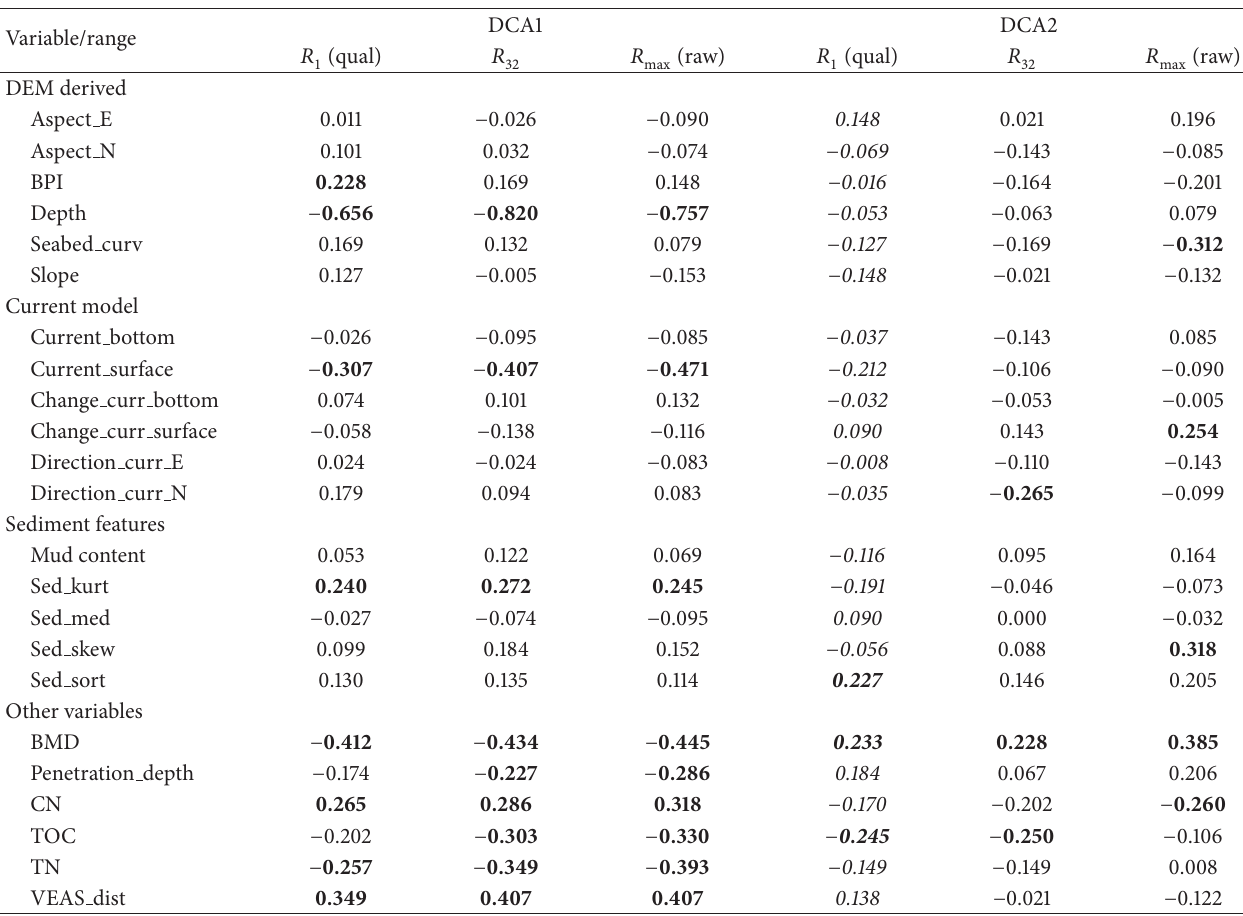
Table 5: Kendall’s 𝜏 correlations between environmental variables and DCA axes 1 and 2 with no ( 𝑅 1 ), intermediate ( 𝑅 32 ), and strong ( 𝑅 max ) weight given to